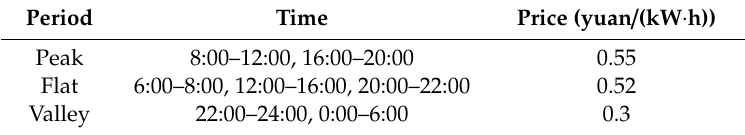
Table 1. Time-of-use price period price.